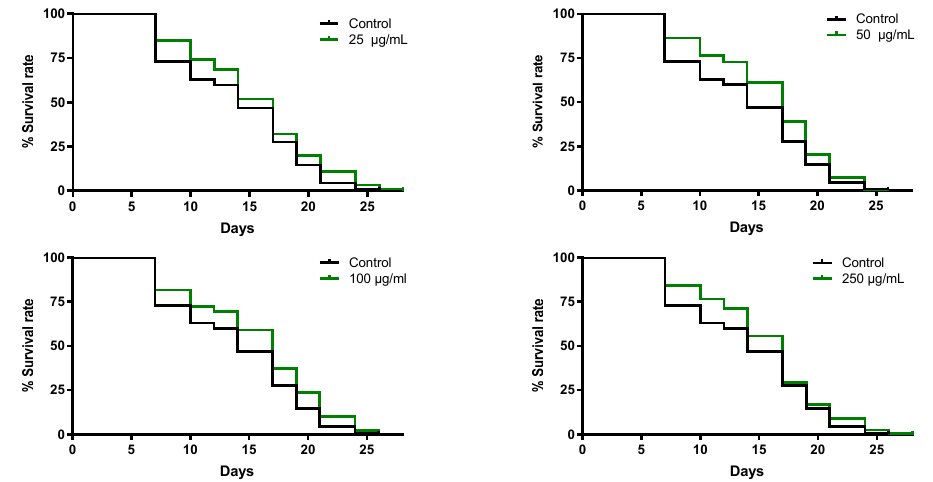
Figure 5. Lifespan of C. elegans SS104 subjected to Borago officinalis flower extract. The mean lifespan was 14 days in control group and 17 days for all treatment groups. Result were analyzed using the Kaplan–Meier survival model and for significance by using a log-rank pairwise comparison test between the control and treatment groups.